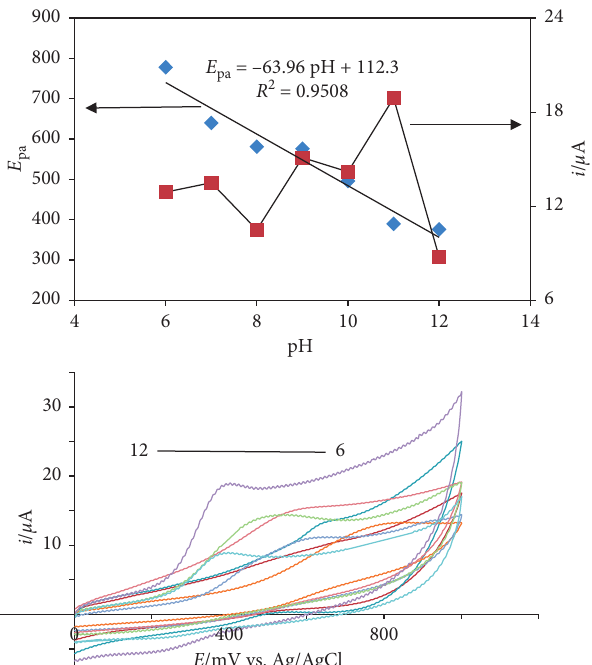
Figure 3: CVs for pH studies using TiO 2 /GNR/GCE for nevirapine in 0.1 M PBS; 100mV/s. Insets: plots of I pa and E pa versus